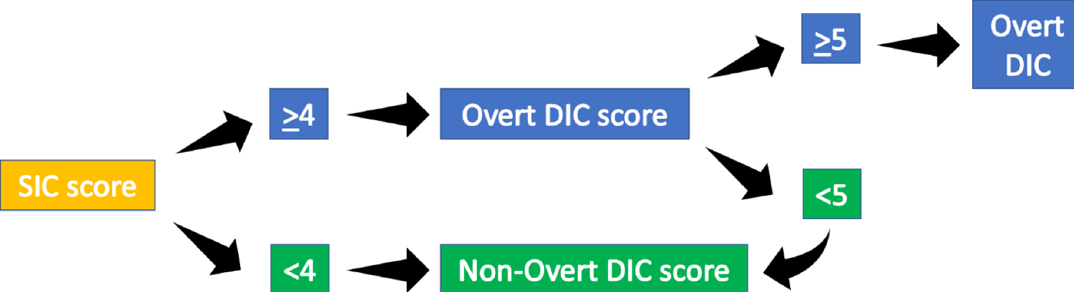
Figure 2. Algorithm that was used in our case series for the screening of overt and non-overt DIC, according to the recommendation of the International Society of Hemostasis and Thrombosis (ISTH).